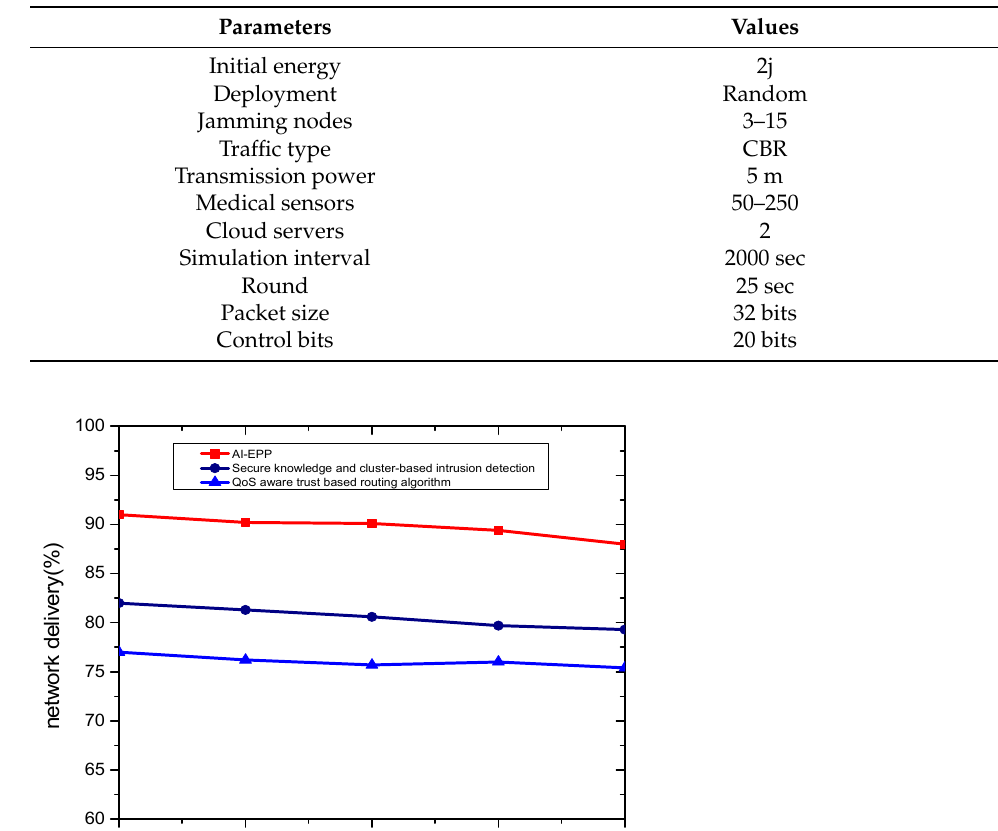
Figure 3. Network delivery comparison using simulations with a varying number of nodes.